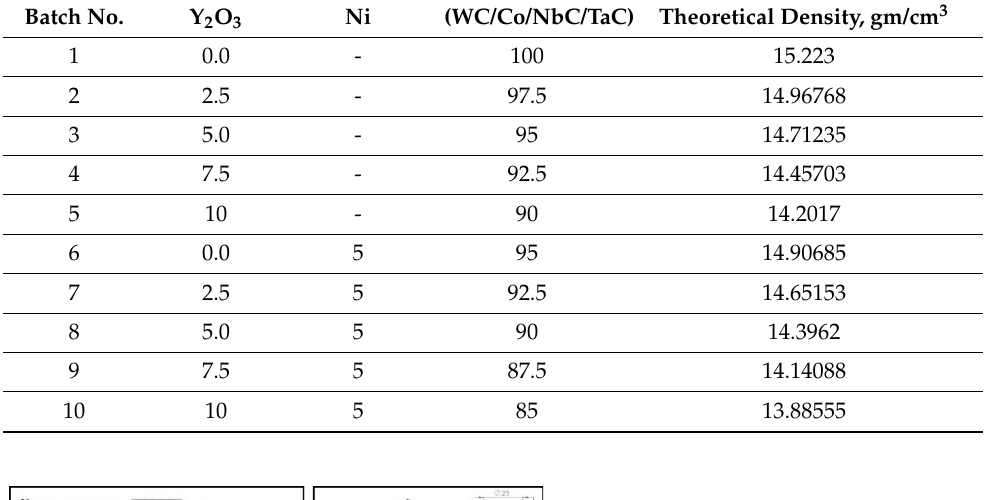
Table 2. The nominal compositions and the mixture-rule-calculated theoretical density of the different batch samples (wt%) produced in this work.